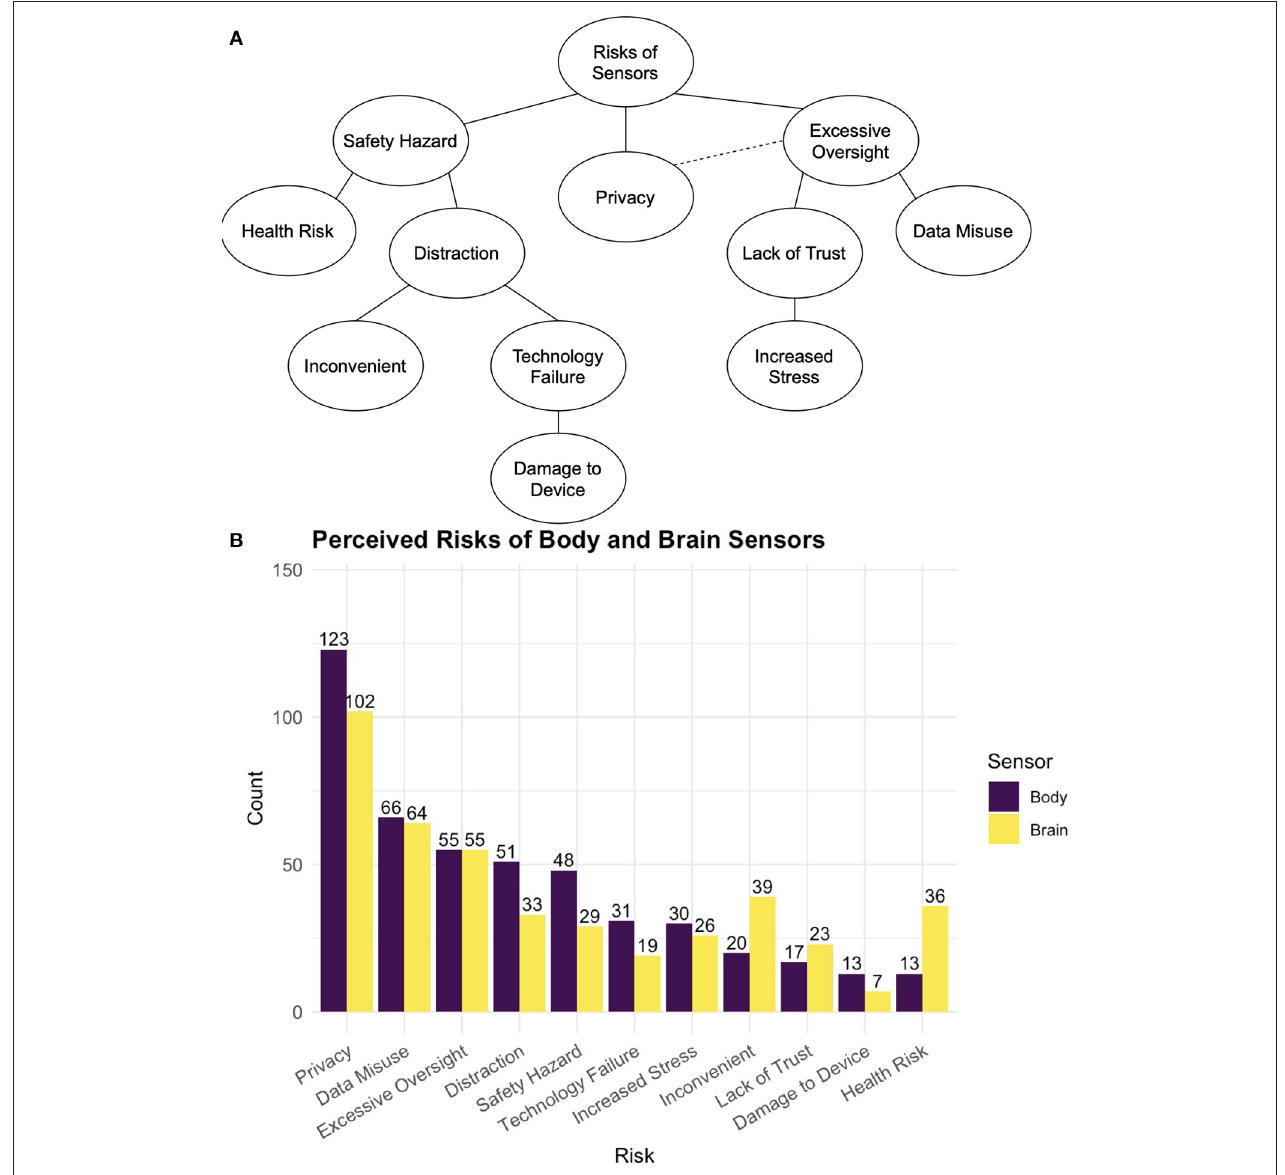
FIGURE 4 | (A) Shows a tree diagram of the themes from free text responses about the perceived hypothetical risk of using sensors in the workplace. (B) Shows the frequency at which each theme was mentioned body and brain sensors.